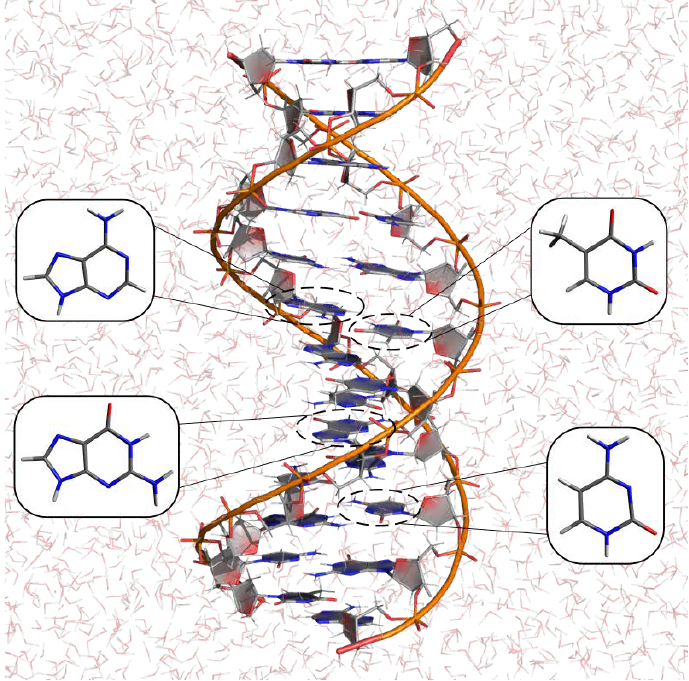
Figure 8. Solvated DNA double strand. The four DNA nitrogenous bases are